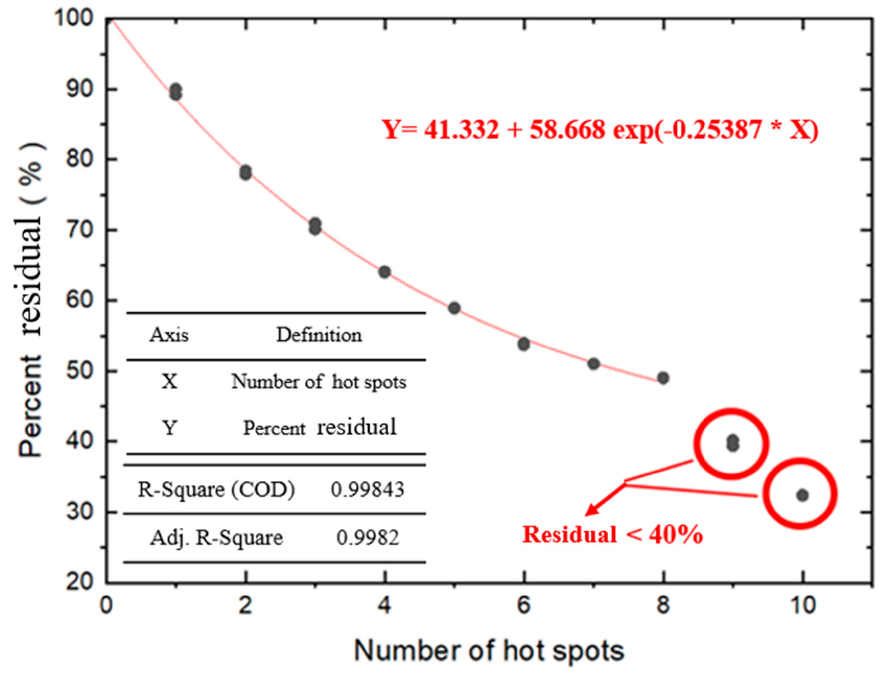
Figure 6. Hotspot number–residual efficiency correlation.